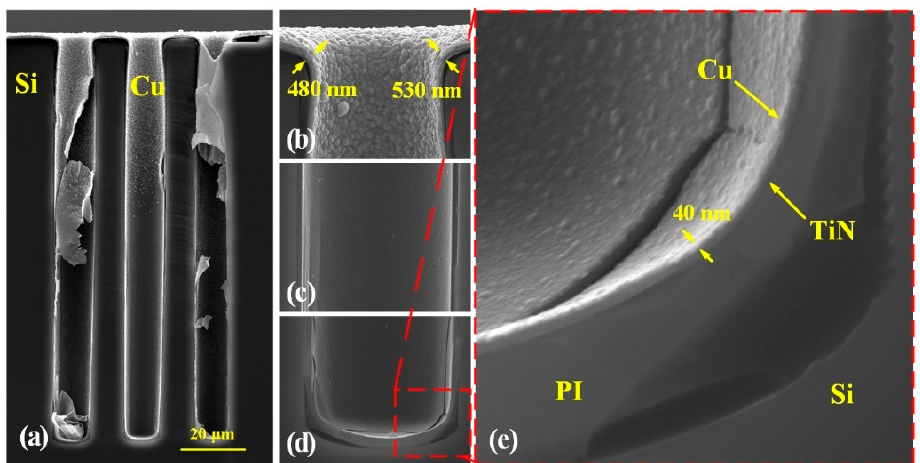
Figure 8. Cross sectional SEM images of fabricated Cu seed layer: ( a ) global view, ( b ) via top, ( c ) via middle, ( d ) via bottom, ( e ) enlarged view of via bottom.